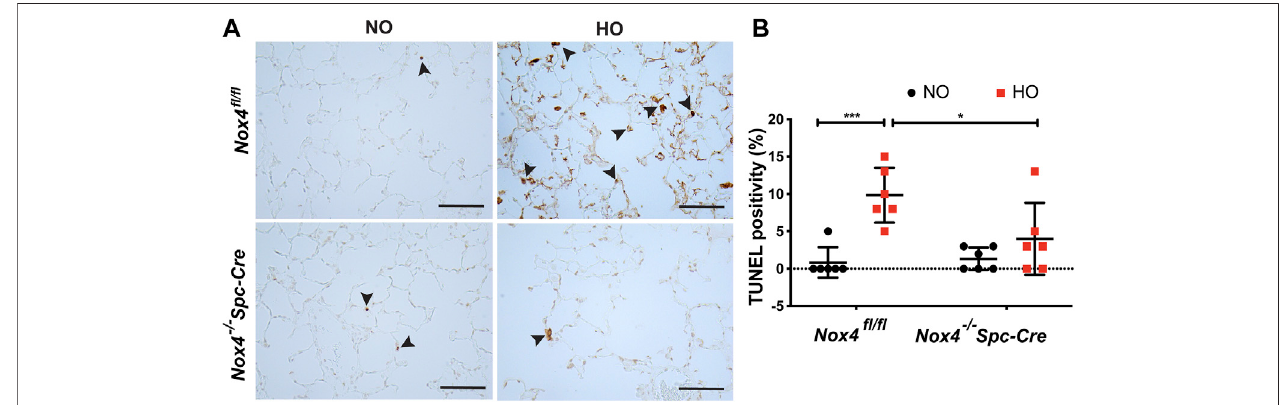
FIGURE 5 | Deletion of Nox4 reduced AT2 cell death induced by HALI. (A) Representative immunohistochemical TUNEL assay micrographs of lung tissues from Nox4 fl / fl and Nox4 − / − Spc-Cre mice exposed to NO or HO (B) The quanti fi ed data indicated a lower percentage of TUNEL-positive apoptotic cells in the